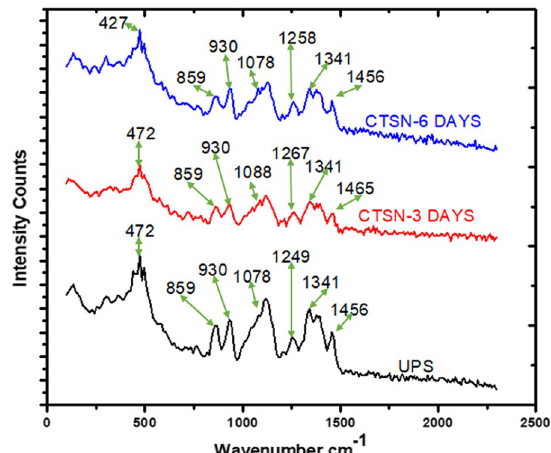
Fig. 5 The overlay of FTIR spectra of UPS, CTSN-3 days, and CTSN-6 days. The comparison of the Fourier transform infrared spectrum